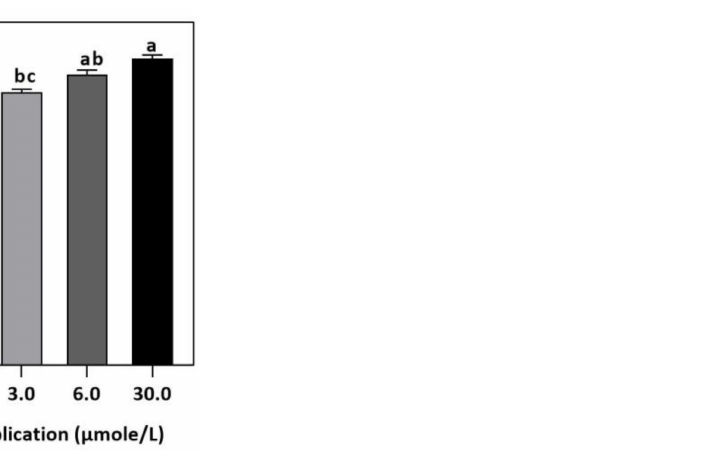
Figure 6. Effect of Cd application of on concentration of Proline E. sativa leaves. Each data value is presented at mean ± SE (n = 5). In Tukey’s multiple range test ( p < 0.05), different letters denote significant differences in columns.